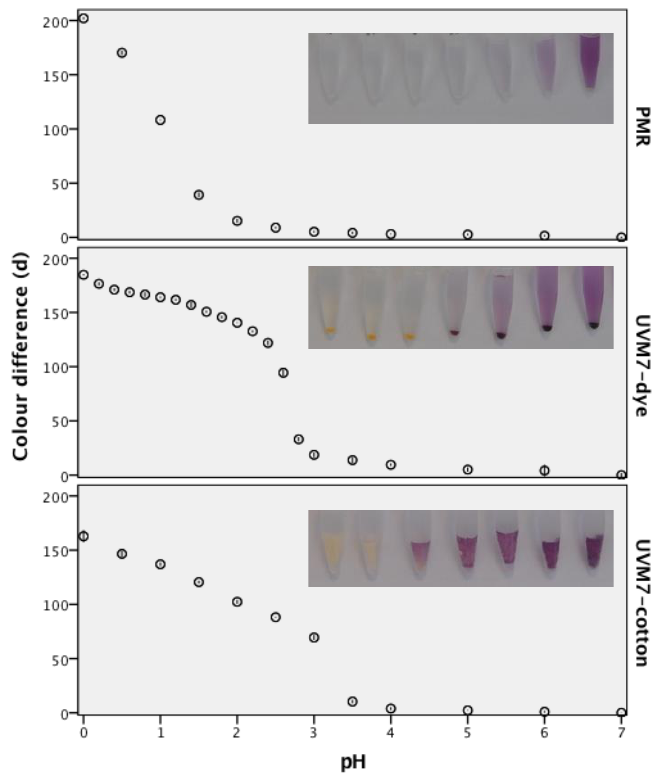
Figure 2. Colour differences and error bars at diverse pH for PMR, UVM7-dye, and UVM7-cotton. Inset: naked eye colour change, from left to right, at pH 4, 3.5, 3, 2.5, 2, 1.5, and 1.